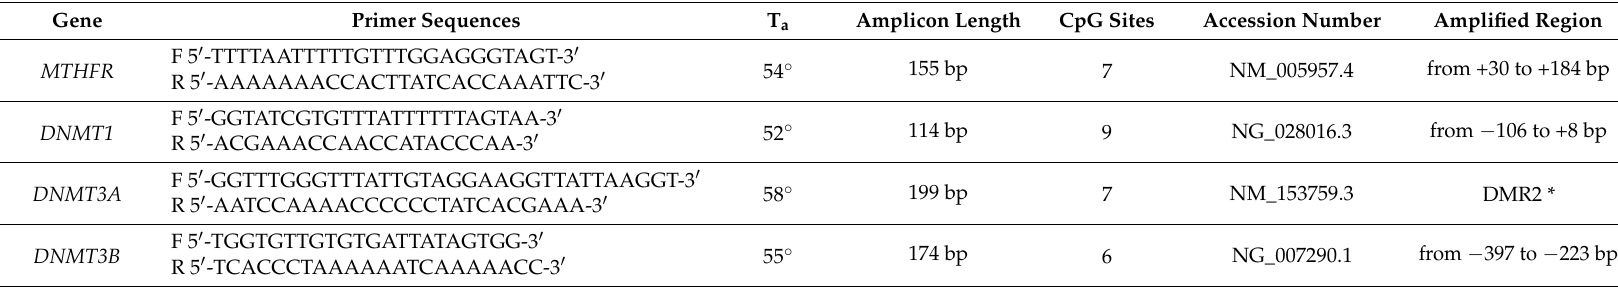
Table 3. Primer sequences and annealing temperatures (T a ) used during MS-HRM analysis, amplicon length, number of CpG sites for each gene, accession number, and amplified region (* DMR2: differentially methylated region = upstream promoter region involved in the regulation of transcript 2 of DNMT3A gene, details are provided in